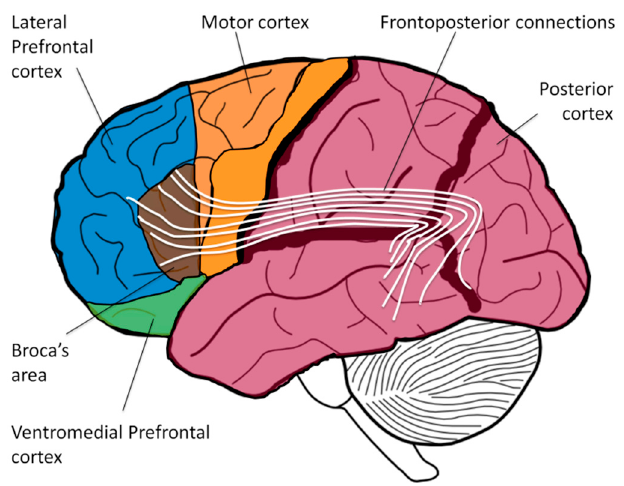
Figure 1. The lateral prefrontal cortex (LPFC) mediates voluntary imagination by exercising control over the posterior cortex via frontoposterior connections, such as arcuate fasciculus and superior longitudinal fasciculus.